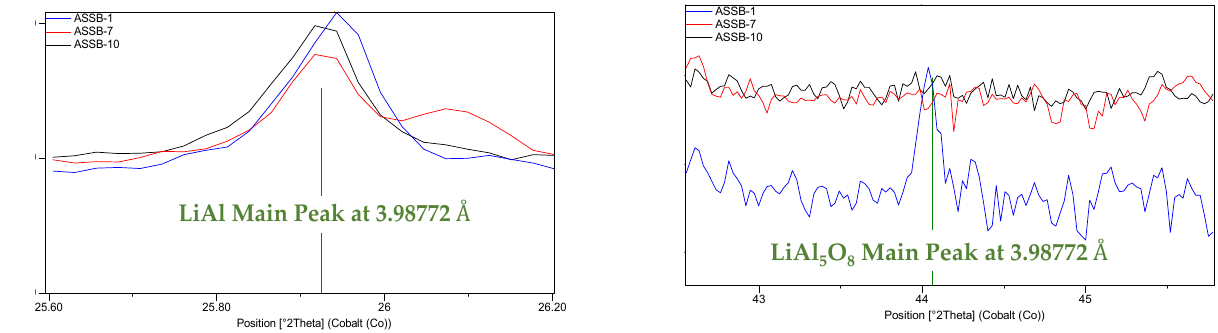
Figure 3. Section of PXRD measurements with the main peaks of LiAl ( left ) and Sp ( right ).